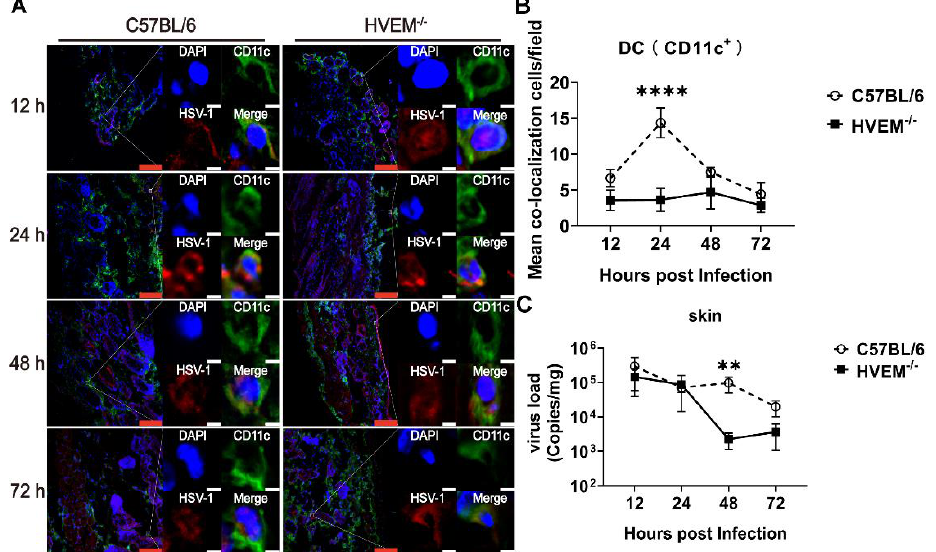
Figure 2. HSV-1 antigen enters dendritic cells in skin tissue and replicates after infection. ( A ) Representative confocal fluorescence images of HSV-1 expression (red), CD11c+ (green) and DAPI (blue) in the skin of C57BL/6 and HVEM −/− mice 12, 24, 48, and 72 h after intradermal infection, taken at 20× magnification under a confocal microscope. The percentage of colocalized cells out of all the dendritic cells was based on the observation of 50 fields. The red scale bar is 100 μm, and the white scale bar is 5 μm. ( B ) Colocalization rate between HSV-1 antigen and a dendritic cell marker after infection ( n = 3 per time point in each group). ( C ) Viral load in local skin tissues at 12, 24, 48, and 72 h after infection ( n = 3 per time point in each group). Statistical significance was assessed by two-way ANOVA with Holm–Sidak adjustment for multiple comparisons (**, p < 0.01; ****, p < 0.0001).